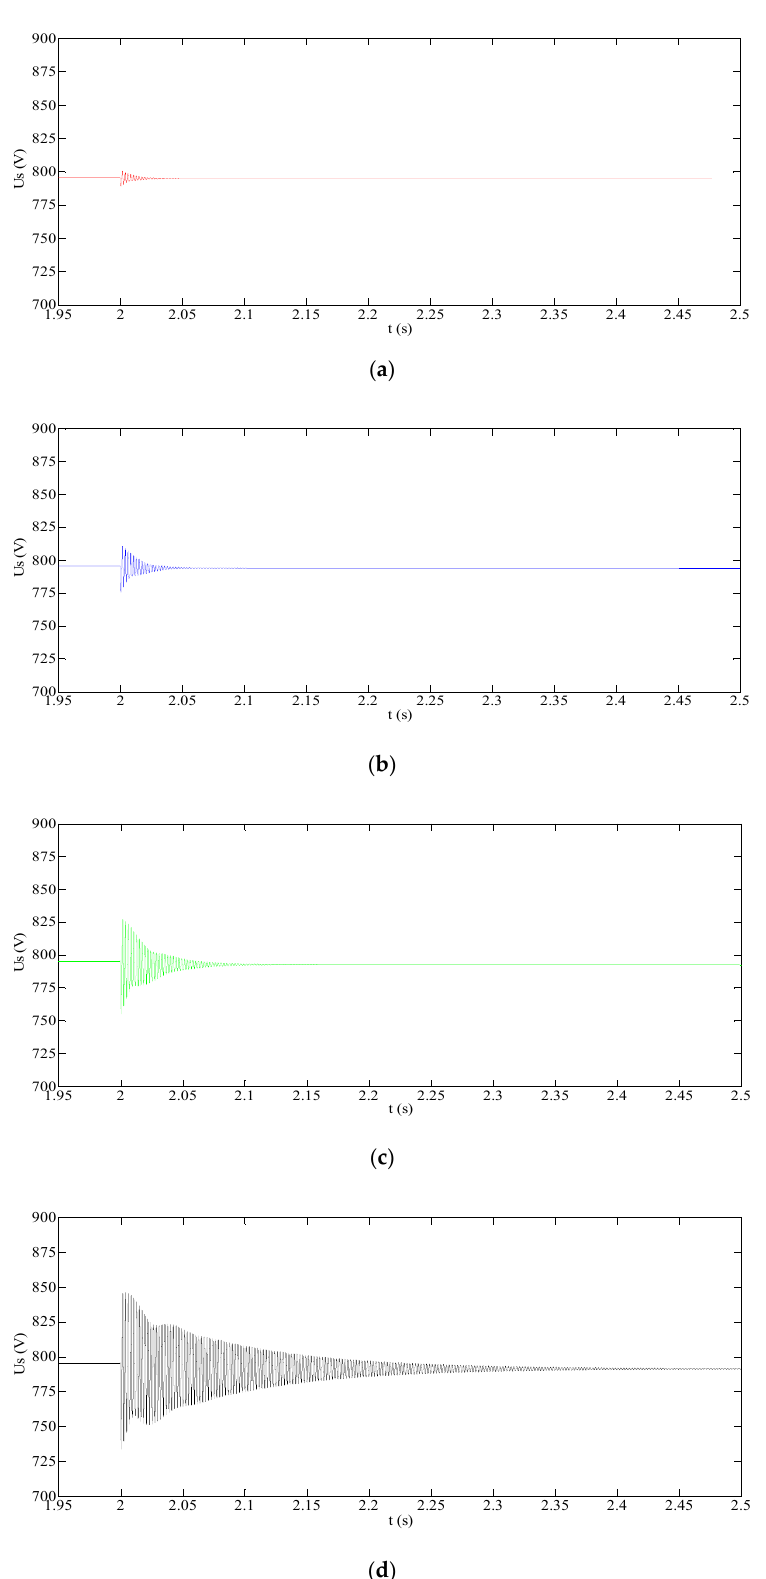
Figure 10. Simulation results of U s : ( a ) P s changes from 90 kW to 100 kW; ( b ) P s changes from 90 kW to 120 kW; ( c ) P s changes from 90 kW to 150 kW; ( d ) P s changes from 90 kW to 180 kW.